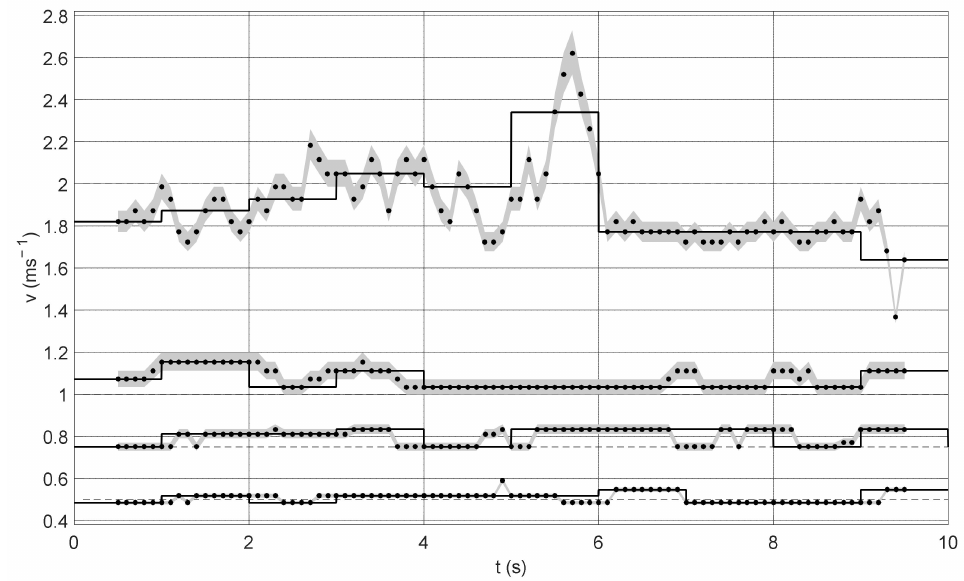
Figure 9. Results obtained after modification of the measurement algorithm: black dots of velocity values obtained for a measurement window with a length of 1 s, shifted every 0.1 s, grey color represents the measurement uncertainty, solid line represents results obtained for a measurement window with a length of 1 s, shifted every 1